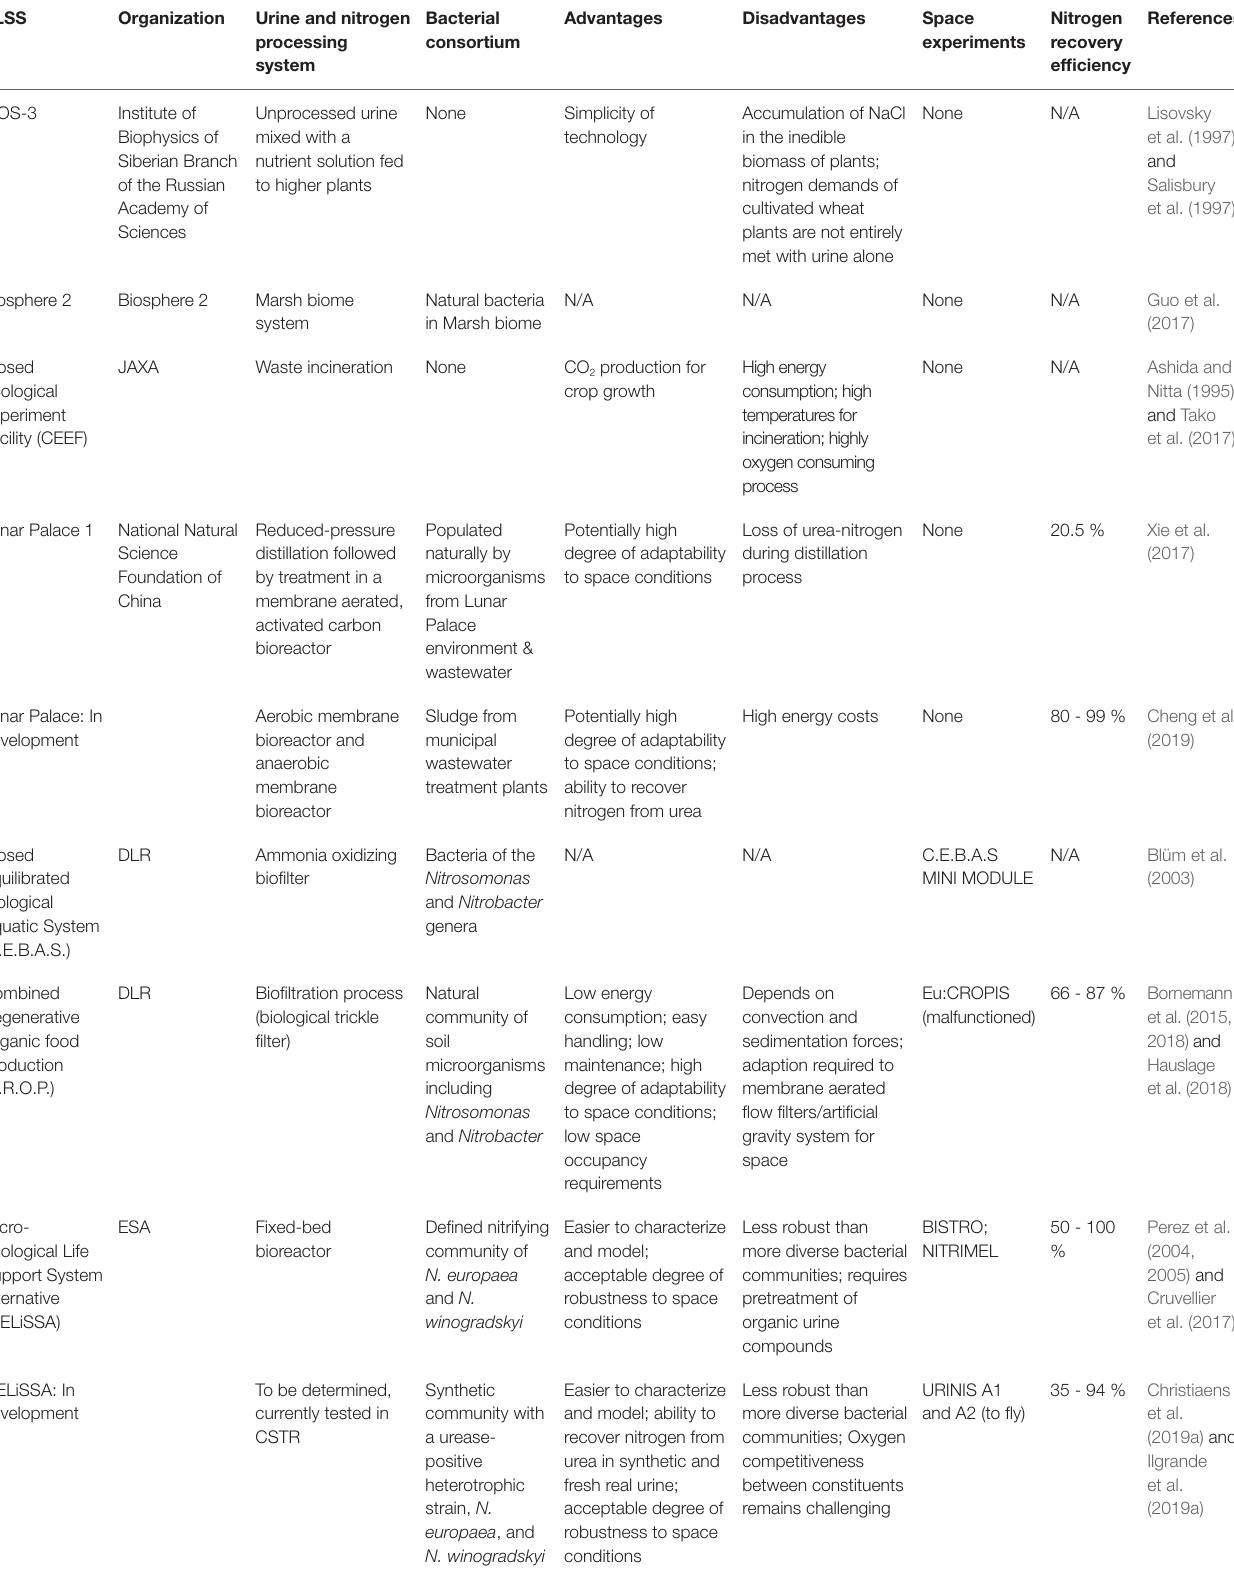
TABLE 1 | Overview of different BLSS